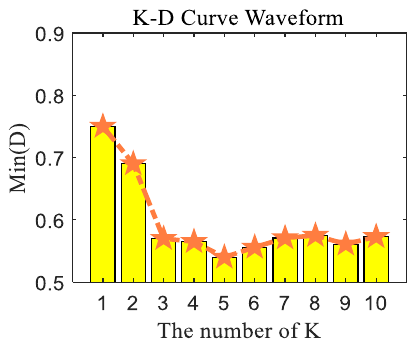
Figure 4. K-D curve waveform.